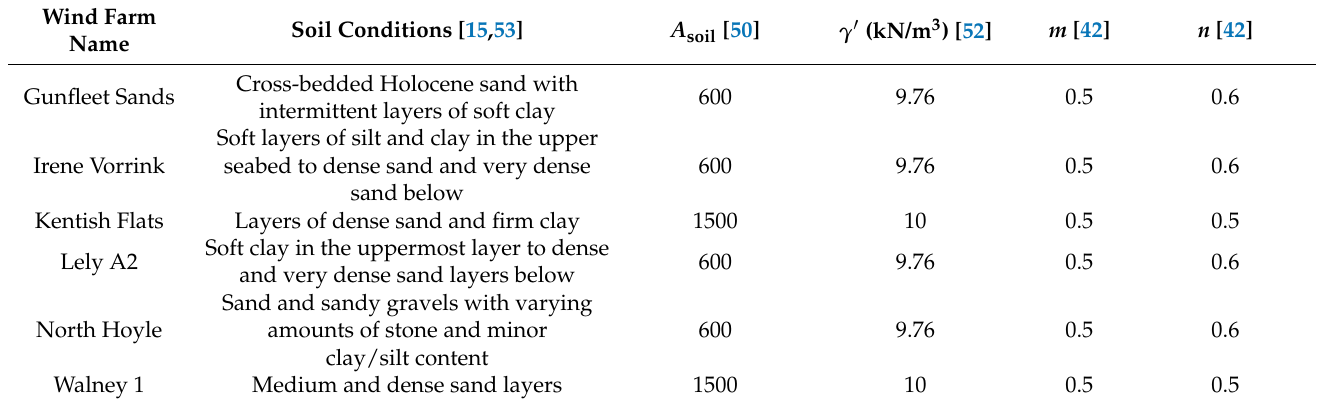
Table 2. Soil conditions and parameters of the six OWTs.